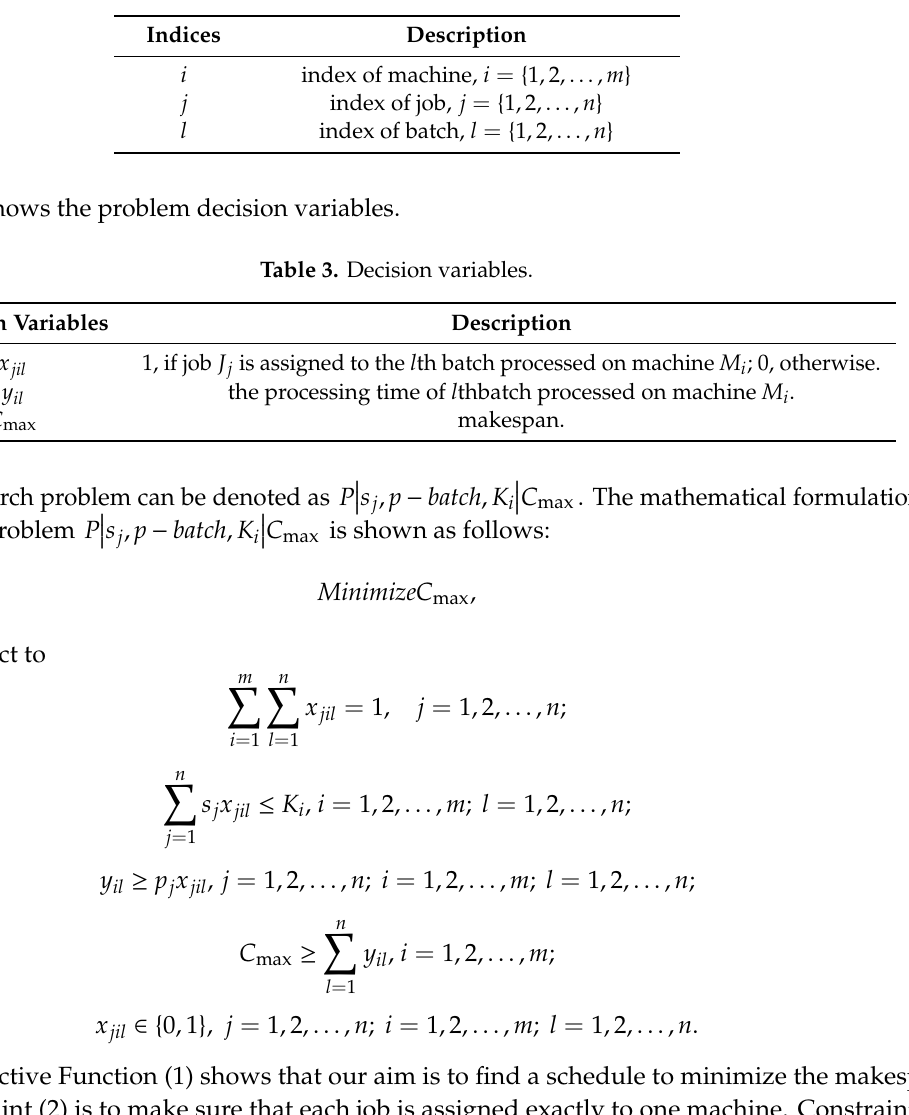
Table 2. Indices.